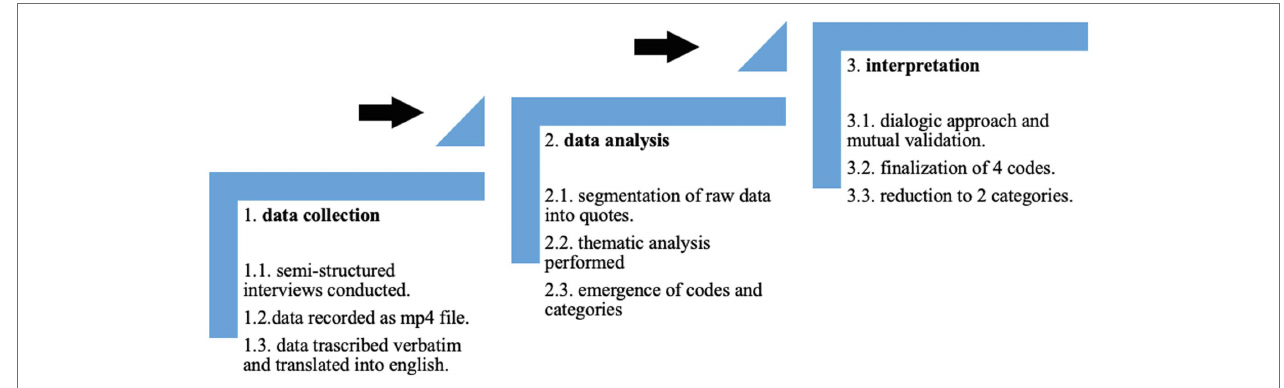
FIGURE 2 | The different steps of data